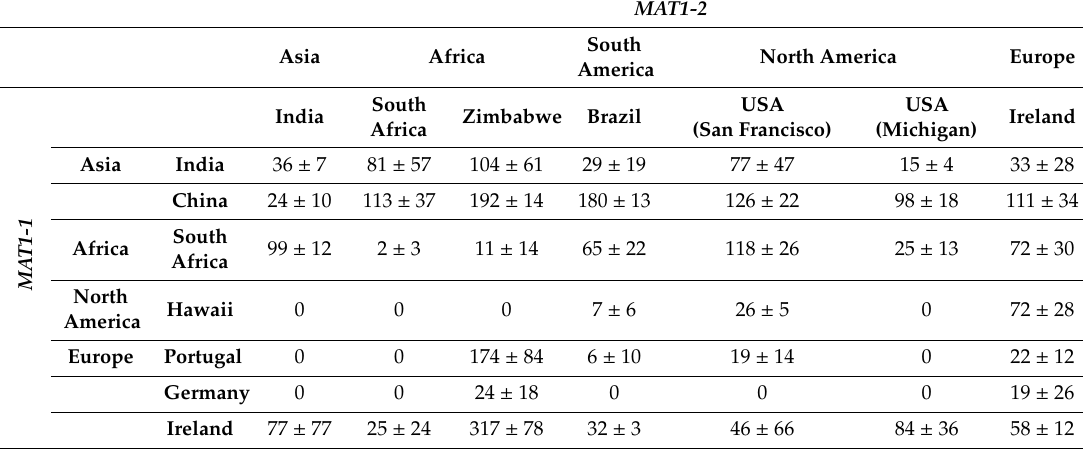
Table 2. Number of cleistothecia produced (per 9 cm Petri dish) in crosses between six isolates of MAT1-1 and six isolates of MAT1-2 genotype of A. fumigatus * from di ff erent continents and countries worldwide. Crossing results with Irish tester strains are included for comparison. Numbers are mean of three replicates ±